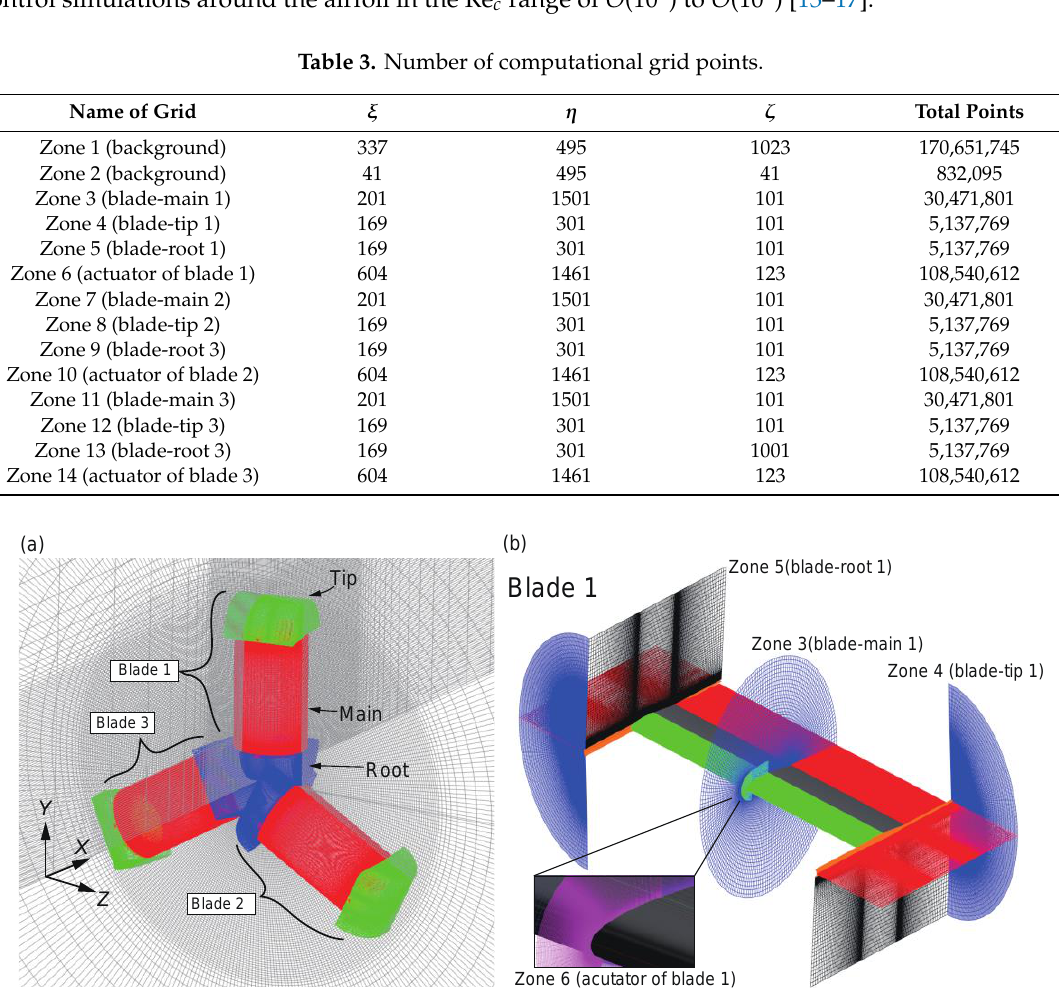
Table 4. Computational cases.